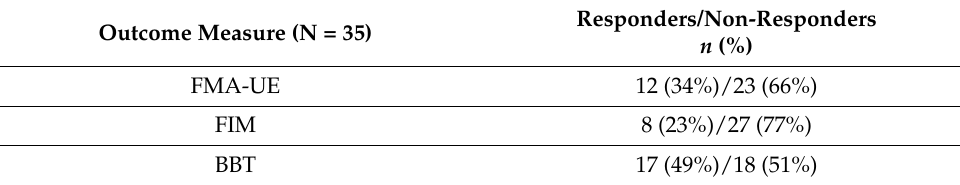
Table 4. Patients responding to therapy in the motor domain.